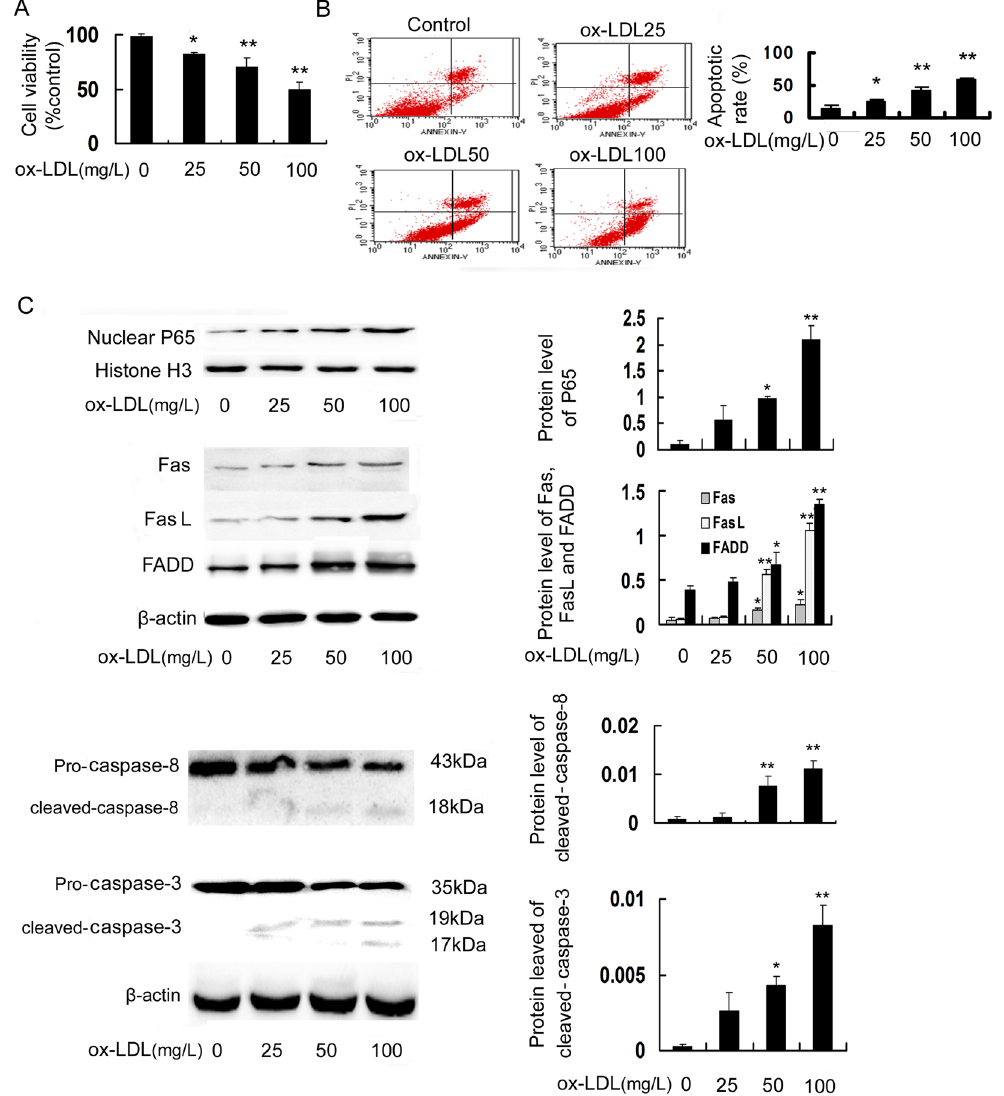
Figure 1. Ox-LDL induces apoptosis, P65 nuclear translocation and the activation of Fas/FasL pathway in RAW264.7 cells. Cells were incubated with ox-LDL (25, 50 and 100 mg/L) for 24 h. ( A ) Cell viability was measured using the MTT assay and expressed as a percentage of the control. ( B ) Cell apoptosis was detected using flow cytometry, and the total apoptotic cells (early and late-stage apoptosis) are presented on the right side of the panel (Annexin V staining alone or together with PI). ( C ) The protein levels of P65 in nuclear extracts and Fas/FasL pathway-related molecules were evaluated by Western blot. Data are expressed as the mean ± SD of at least three independent experiments. * P < 0.05 and ** P < 0.01 versus vehicle-treated